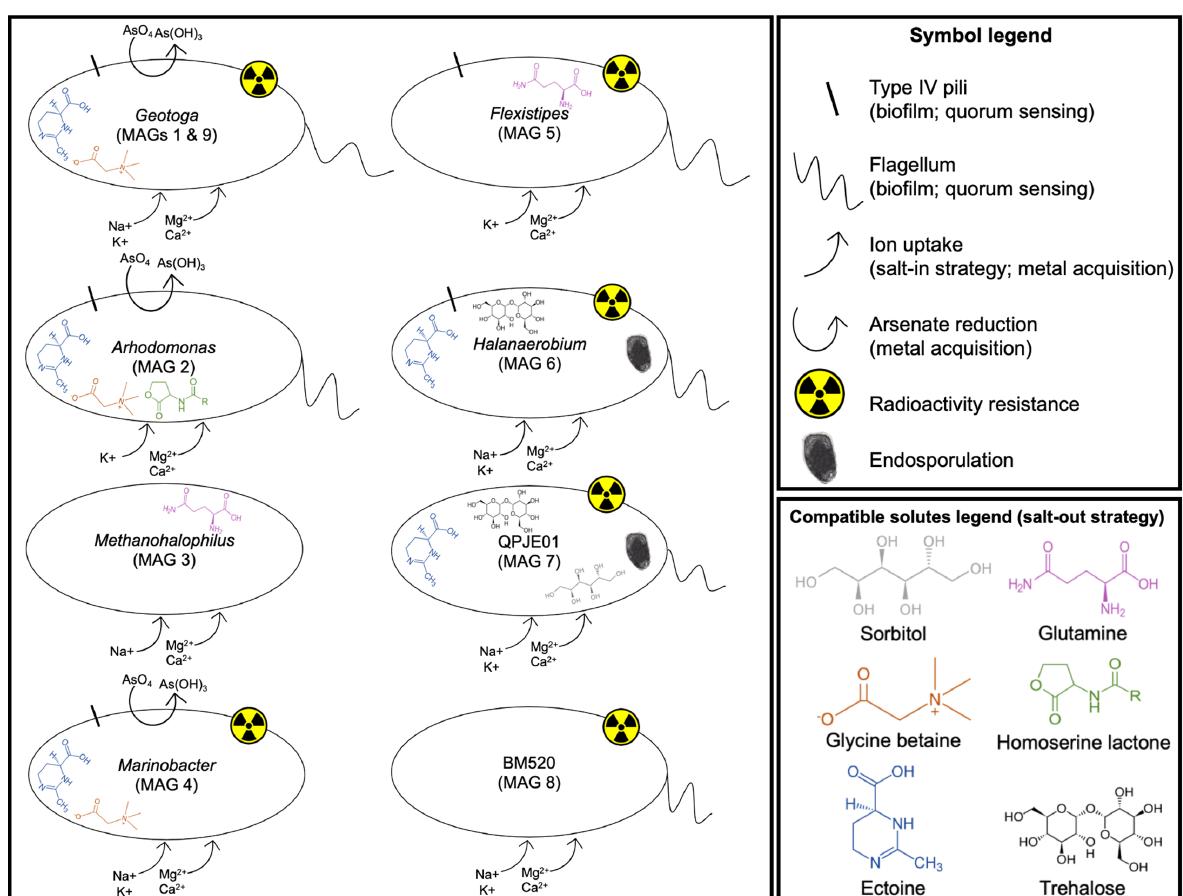
Figure 5. Potential environmental adaptations encoded in genomes from members of a Gulf of Mexico oil reservoir microbiome. Results from two Geotoga genomes (MAGs 1 and 9) are similar and are depicted together.